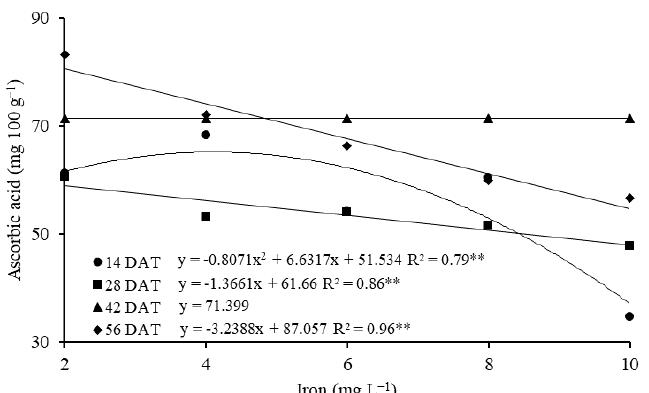
Figure 4. Leaf contents of chlorophyll a, chlorophyll b, chlorophyll a + b and carotenoids in collard greens as a function of iron concentration in the nutrient solution at 14, 28, 42 and 56 days after the application of treatments (DAT). Significant at * p ≤ 0.05 and ** p ≤ 0.01.